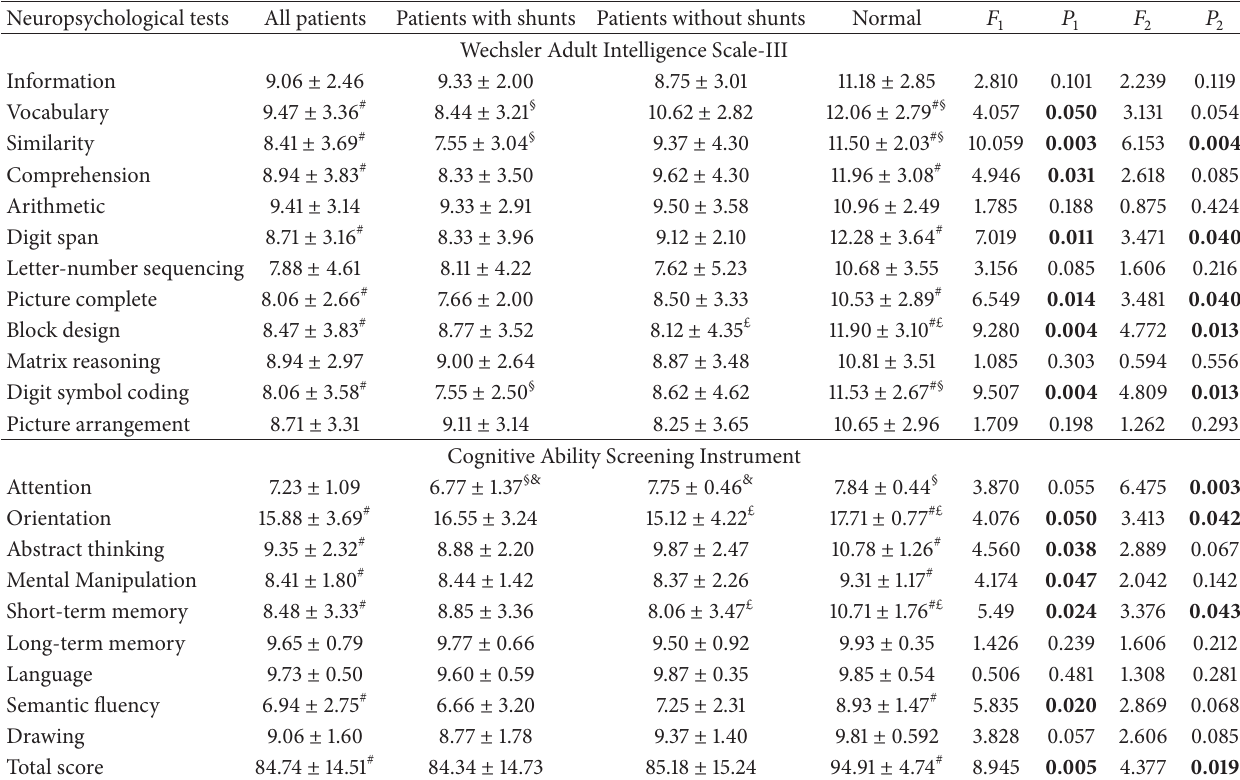
Table 3: Neuropsychological rating scores among